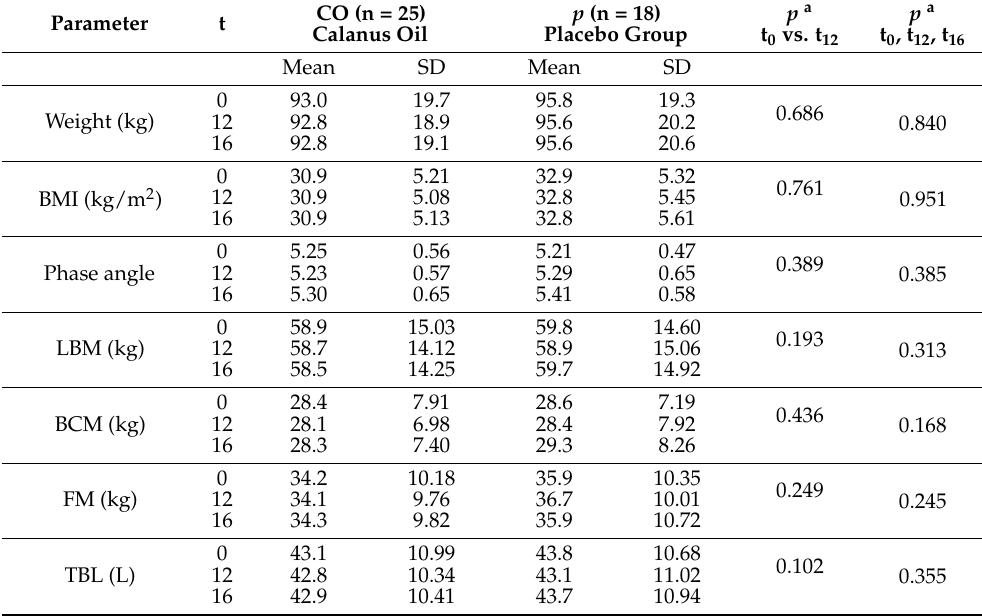
Values are given as mean ± SD. BMI, body mass index; LBM, lean body mass; BMC, body cell mas; FM, fat mass; TBW, total body water. p a -values represent the time intervention interaction analysed with a two-way repeated